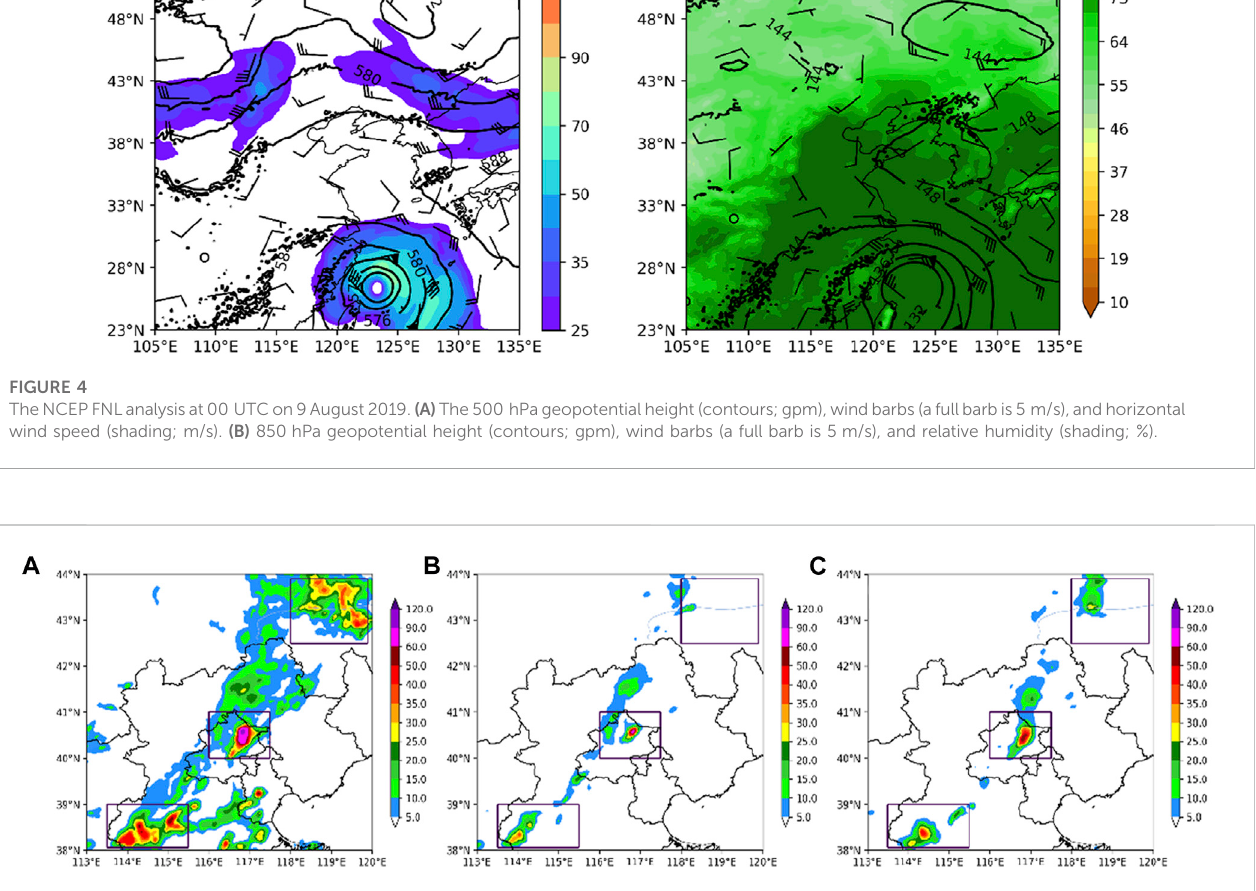
FIGURE 5 Distribution of (A) 6-hr accumulated rainfall starting from 06 UTC on 9 August 2019, and hourly rainfall on (B) 08 UTC, and (C) 09